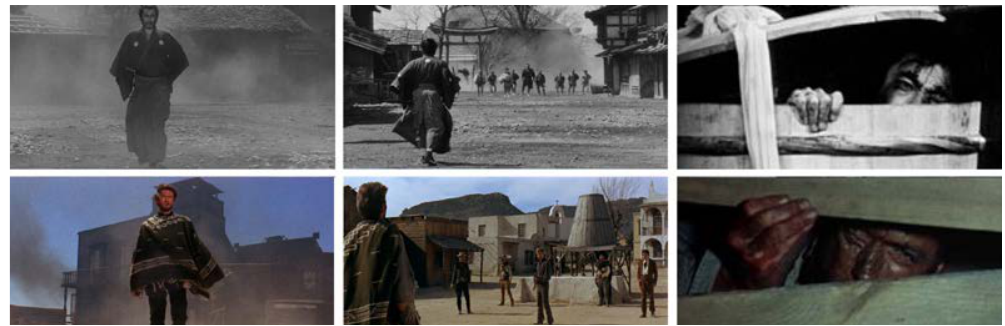
Fig. 11 Akira Kurosawa, Yojimbo , 1961 (above); Sergio Leone, A Fistful of Dollars , 1964